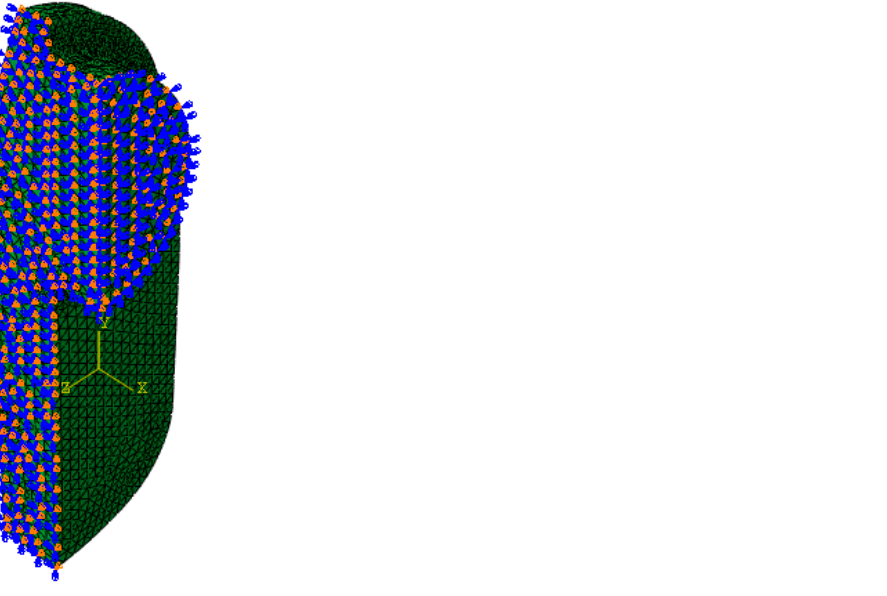
Figure 10. Displacement boundary conditions of the crankshaft for the residual stress analysis.